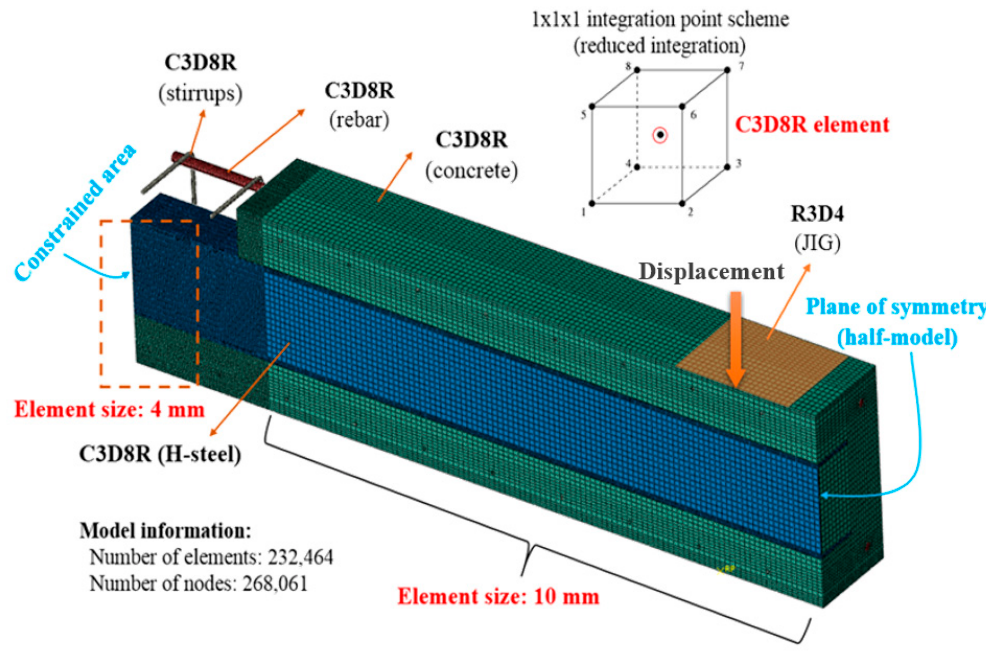
Figure 6. Elements selected for the FE model.